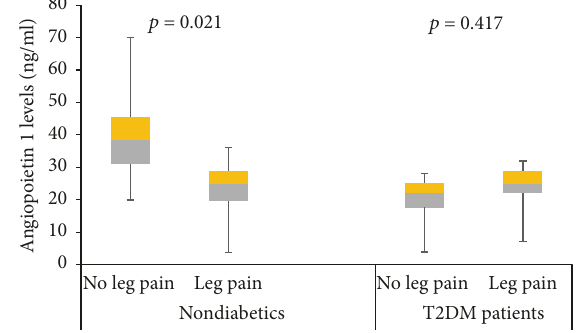
Figure 2: Circulating levels of angiopoietin 2 among patients with leg pains based on their diabetes status. Data presented as median interquartile range and analysed with Mann–Whitney test.